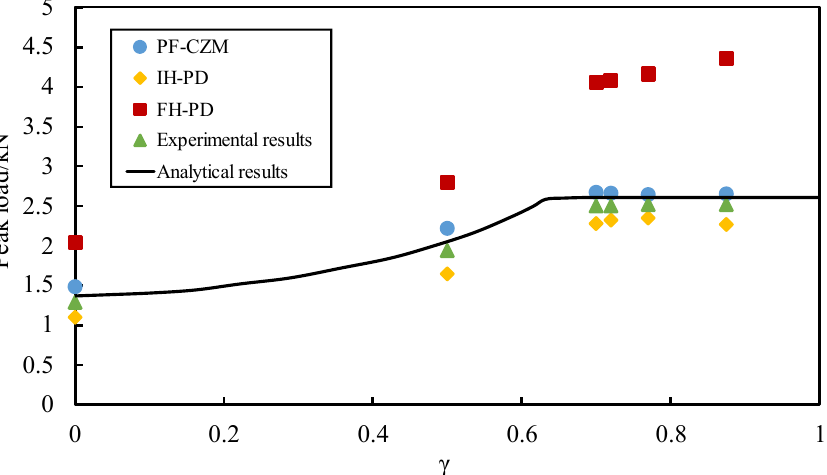
Figure 9. Comparison of peak loads with different γ values from PF-CZM, IH-PD, FH-PD [44], the experimental results and the analytical solution